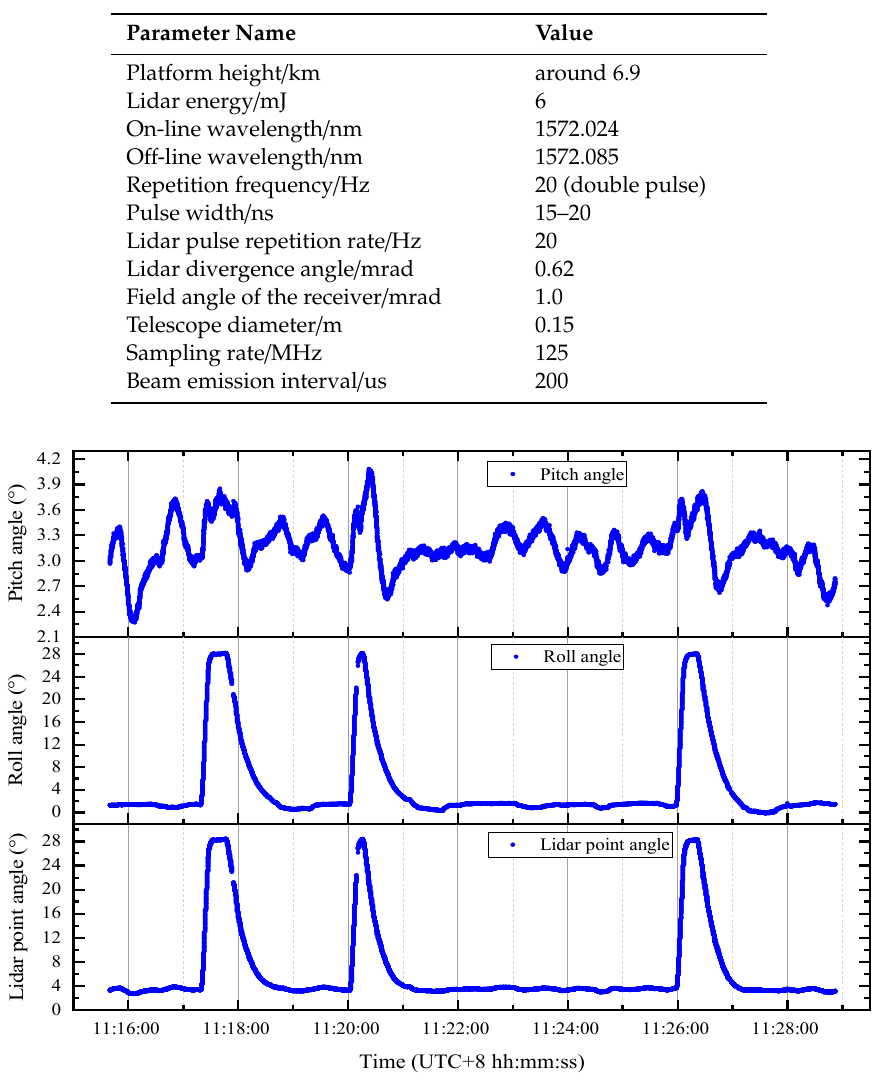
Figure 5. Airborne angle information. The corrected pitch angle, roll angle, and laser pointing angle are shown, respectively. The angle between the laser beam pointing and the vertical line is called the laser pointing angle, which is calculated from the pitch and the roll angle by using Equation (2). There are two breakpoints in the graph because there is one second missing data at two different locations in the original data.